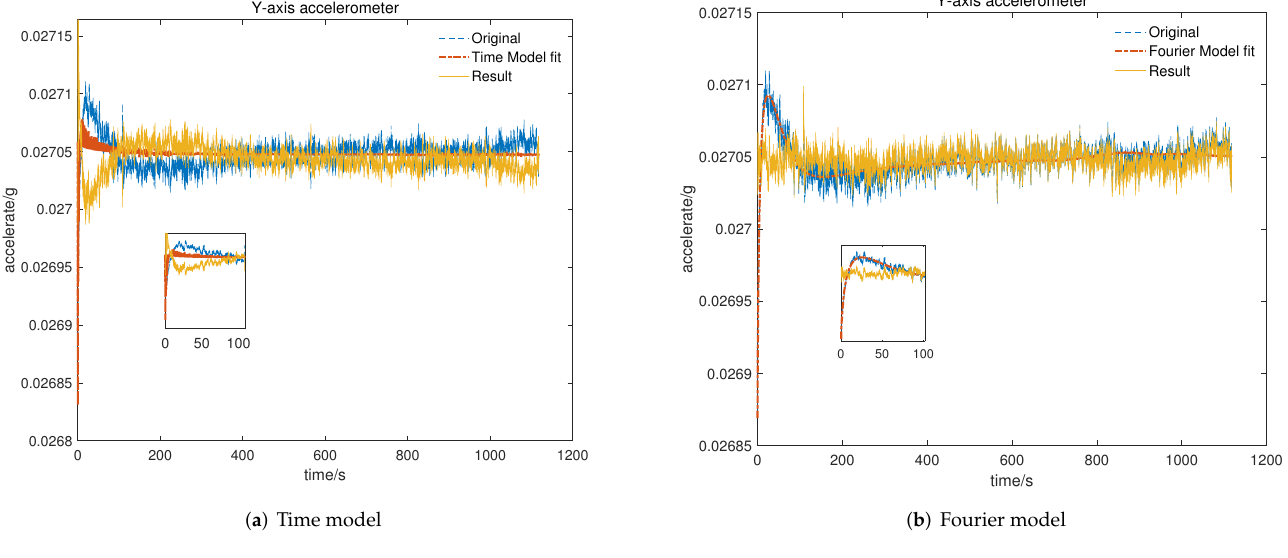
Figure 8. Result of temperature compensation for Y -axis accelerometer: ( a ) compensation with time-related model; ( b ) compensation with Fourier-related model. Table 1. Indexes of accelerometer in cold start-up stage before and after temperature